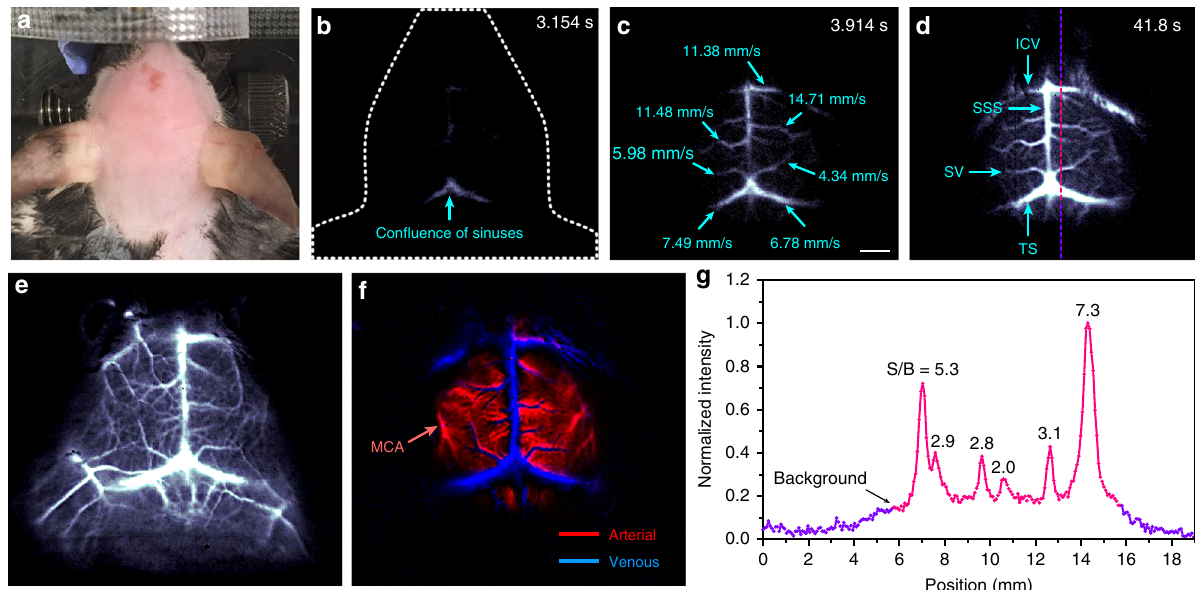
Fig. 4 Fast in vivo brain imaging with Er-RENPs@PMH-PEG in the NIR-IIb region. a Color photograph of a C57Bl/6 mouse (with hair shaved off) preceding NIR-IIb fl uorescence imaging. b – d Time-course NIR-IIb brain fl uorescence images (exposure time: 20 ms) showing the perfusion of RENPs into various cerebral vessels. The blood- fl ow velocities of cerebral vessels are given in c (scale bar corresponds to b – d : 2 mm). e , f Cerebral vascular image (exposure time: 20 ms) in NIR-IIb region with corresponding PCA overlaid image f showing arterial (red) and venous (blue) vessels. g SBR analysis of NIR-IIb cerebrovascular image d by plotting the cross-sectional intensity pro fi